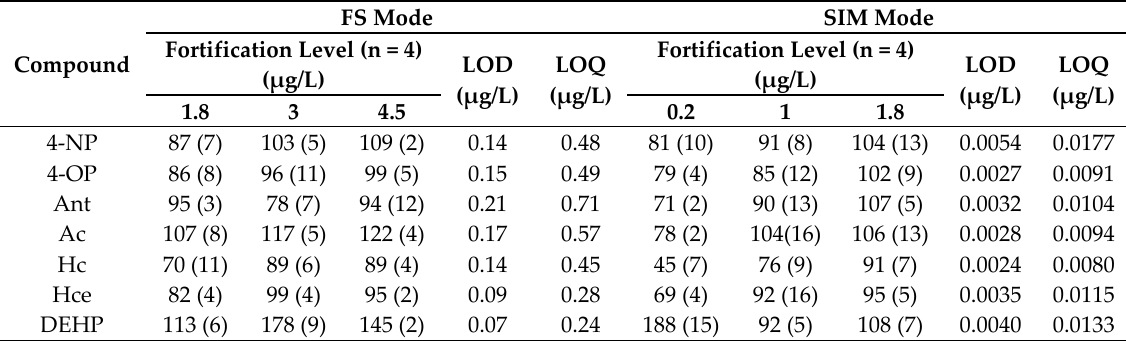
Table 2. Average recovery values (%) obtained using the GC-MS method both in full scan (FS) and SIM mode with Relative Standard Deviation values (parenthesis) at three different concentration levels and limits of detection (LOD) and (limits of quantification) LOQ values for both methods. FS Mode SIM Mode Fortification Level (n = 4) Compound (µg/L)